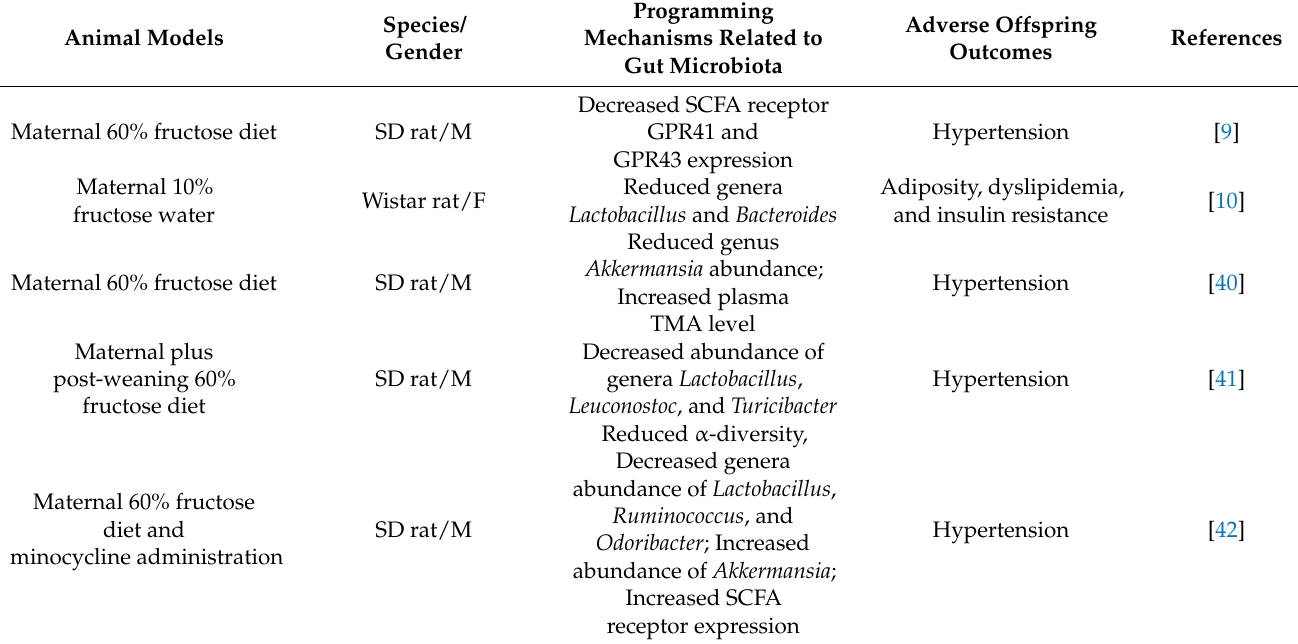
Table 1. Maternal high-fructose diet-induced adult disease of developmental origins related to gut microbiota dysbiosis in animal